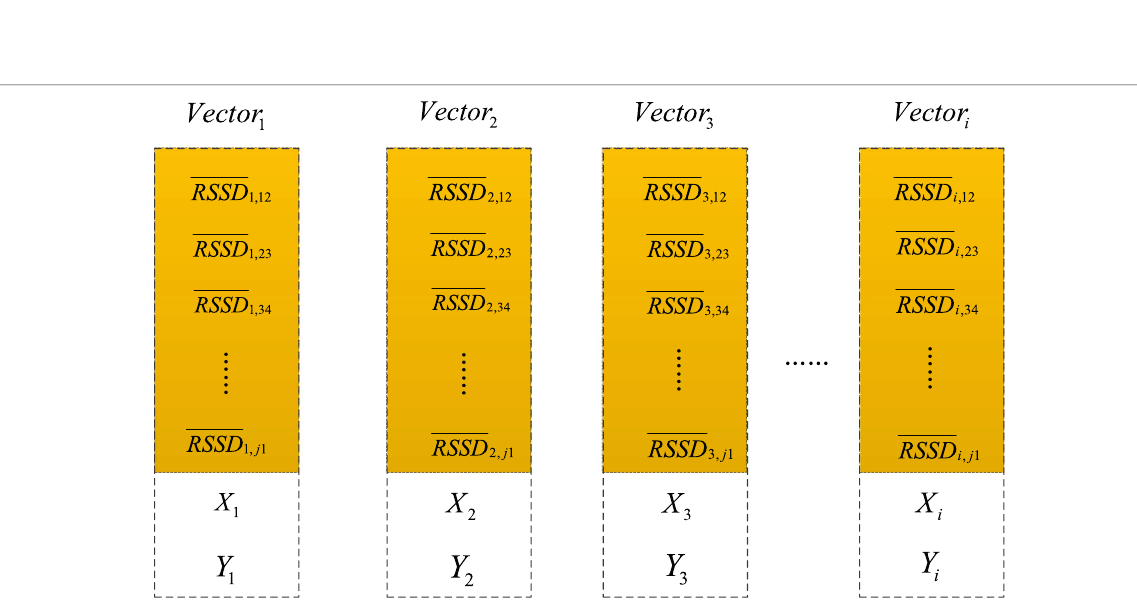
Fig. 5 Structure of the proposed RSSD-based database. vector (cid:2) i represents the data vector of i -th reference point, which contains coordinates and RSSD